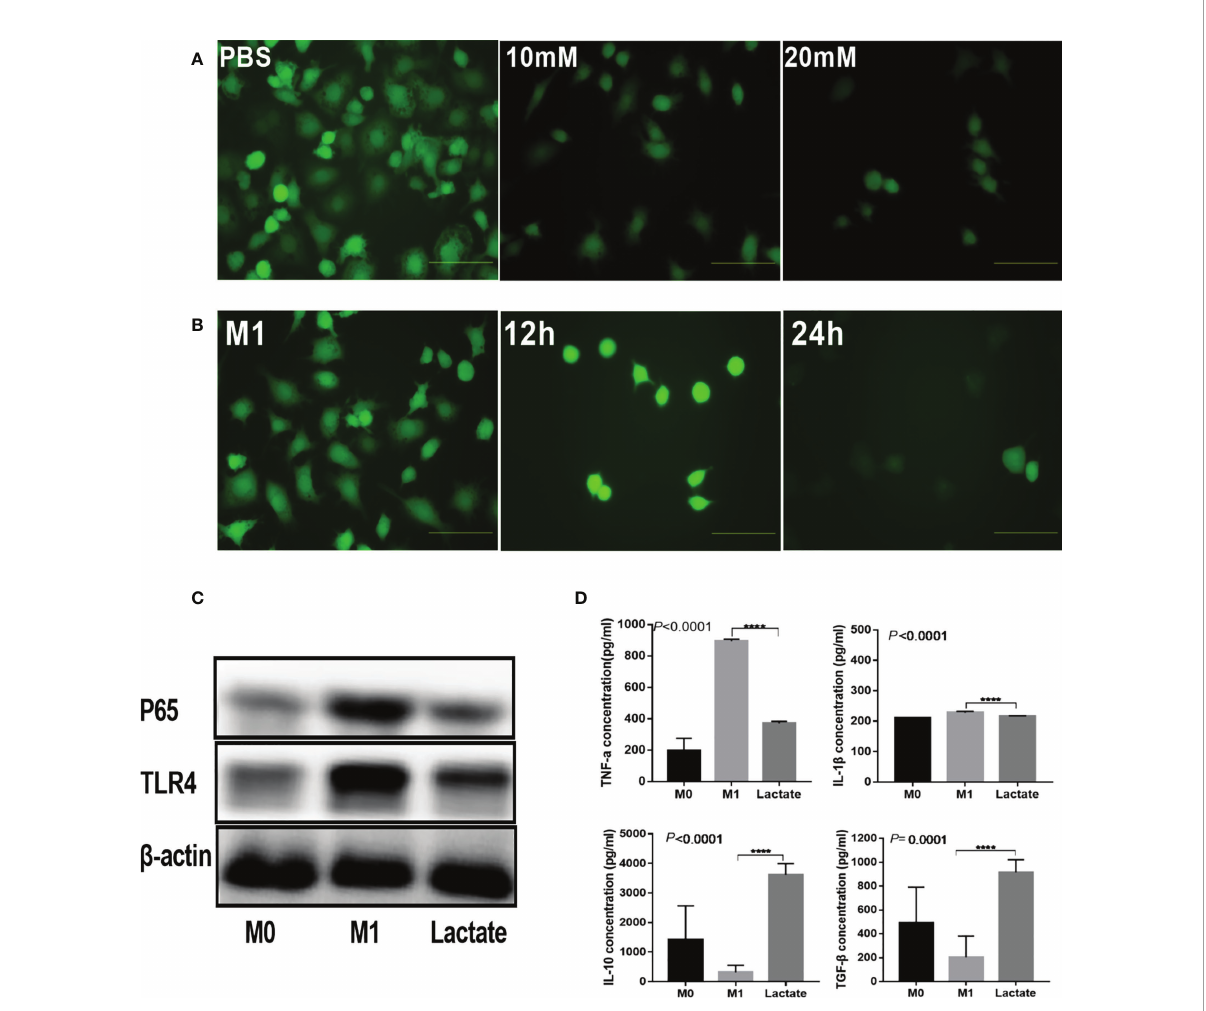
FIGURE 2 Lactate inhibited in fl ammation in vitro. (A) Intracellular ROS generation was observed using a ROS fl uorescence probe DCFH-DA after lactate treatment (n = 3). scale bar, 5 m m. (B) Intracellular ROS generation by macrophages at different time points (n = 3). scale bar, 5 m m. (C) Western blotting results showing expression of phenotypic markers of LPS-stimulated macrophages after lactate treatment (n = 3). (D) In fl ammatory cytokines released by macrophages in different treatment groups determined by ELISA (n=6). Pro-in fl ammatory cytokines, TNF- a and IL-1 b ; Anti-in fl ammatory factors, TGF- b and